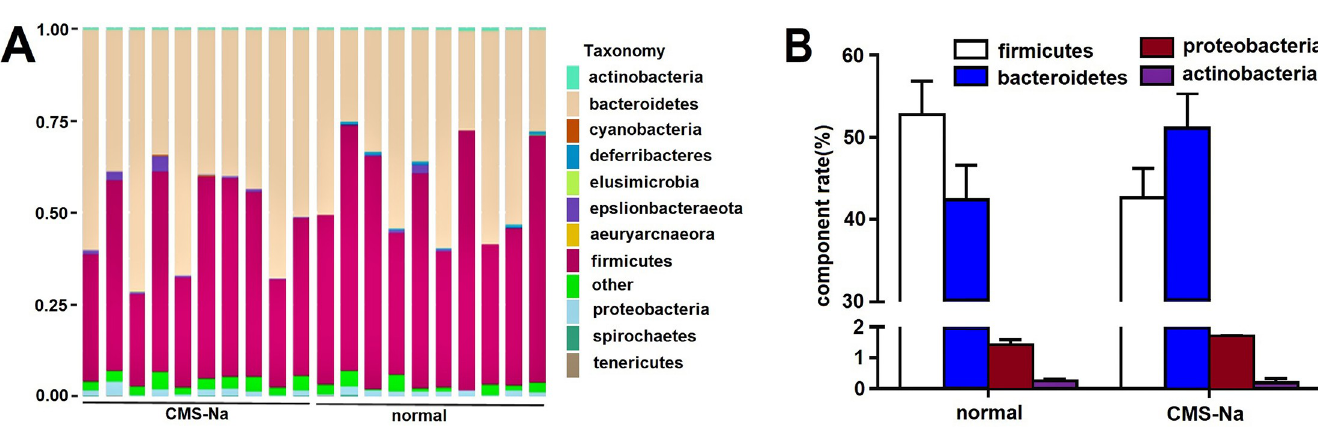
Fig 6. Effects of CMS-Na on different intestinal flora in rats. (A) CMS-Na modulated the composition of the gut microbiota at different phylum levels. (B) Effect of CMS-Na on four different phylum levels. Mean ± SD, n = 10.